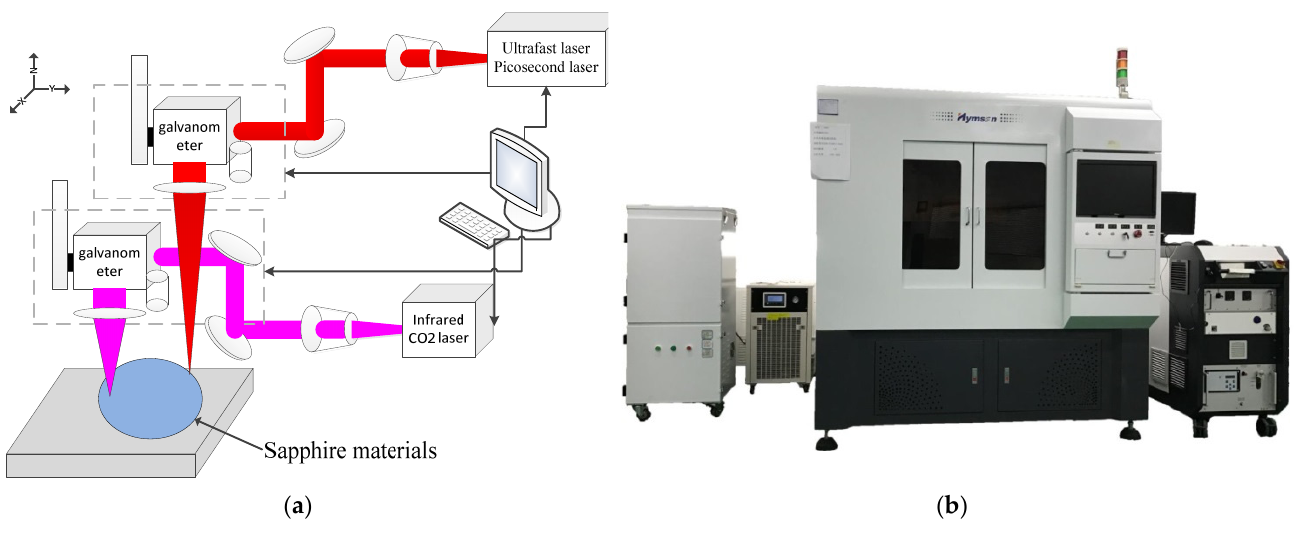
Figure 10. Ultrafast double-laser beam cutting machine equipment. ( a ) Schematic diagram of ultrafast double-laser beam cutting. ( b ) photograph of the laser-cutting equipment.